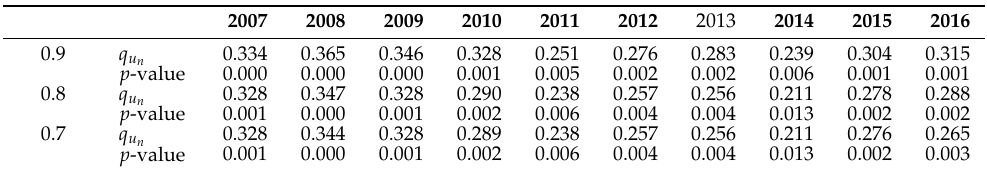
Table 10. The TQCC estimation between RCI (non-rolling window) and regional carbon efficiency from 2007 to 2016 with uq = 0.9, 0.8 and 0.7.